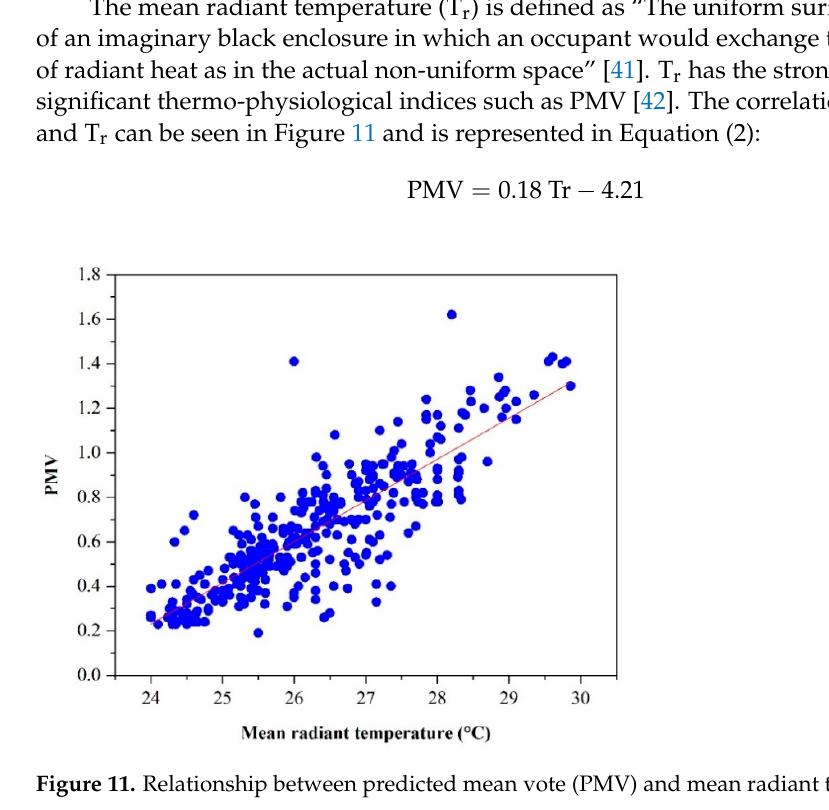
Figure 12. Relationship between mean radiant temperature (T r ) and indoor air temperature. 3.5. Effect of Thermal Insulation of Clothing on Patients’ Thermal Comfort The amount of thermal insulation worn by people has a substantial impact on their thermal comfort [45]. The estimation of clothing insulation took into account all the gar- ments worn by people such as underwear, t-shirts, socks, shorts, shoes, summer dresses, light skirts, and leggings. The estimation of clothing insulation took into account all the